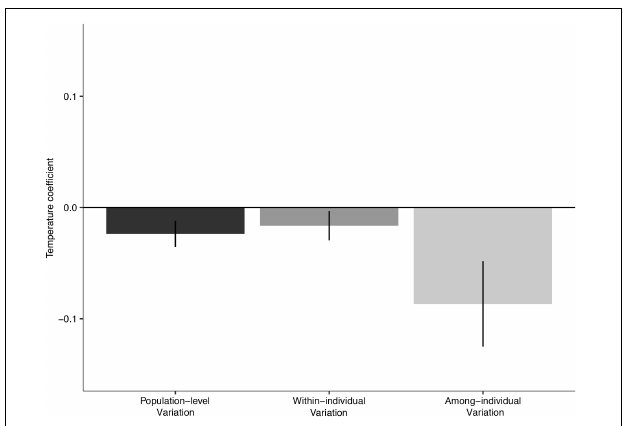
FIGURE 4 | Winter temperature-related population-level variation, compared with within-individual (representing evolutionary-fixed phenotypically plastic responses), and among-individual (representing facultative environmental responses)